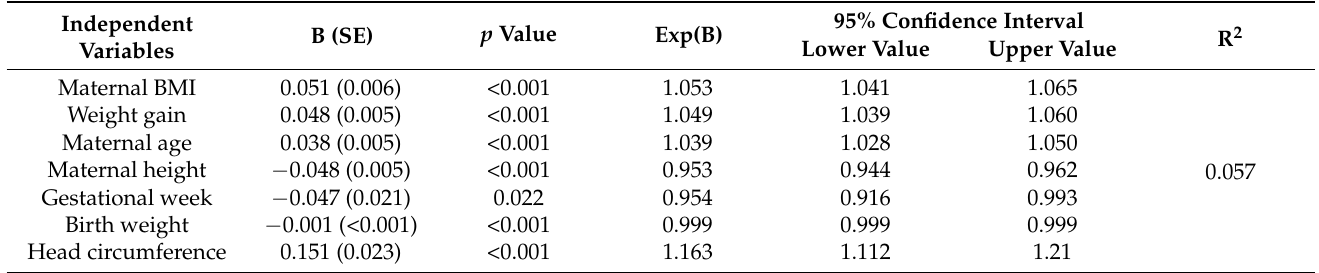
Table 3. Maternal and foetal parameters associated with emergency caesarean section. Binary logistic